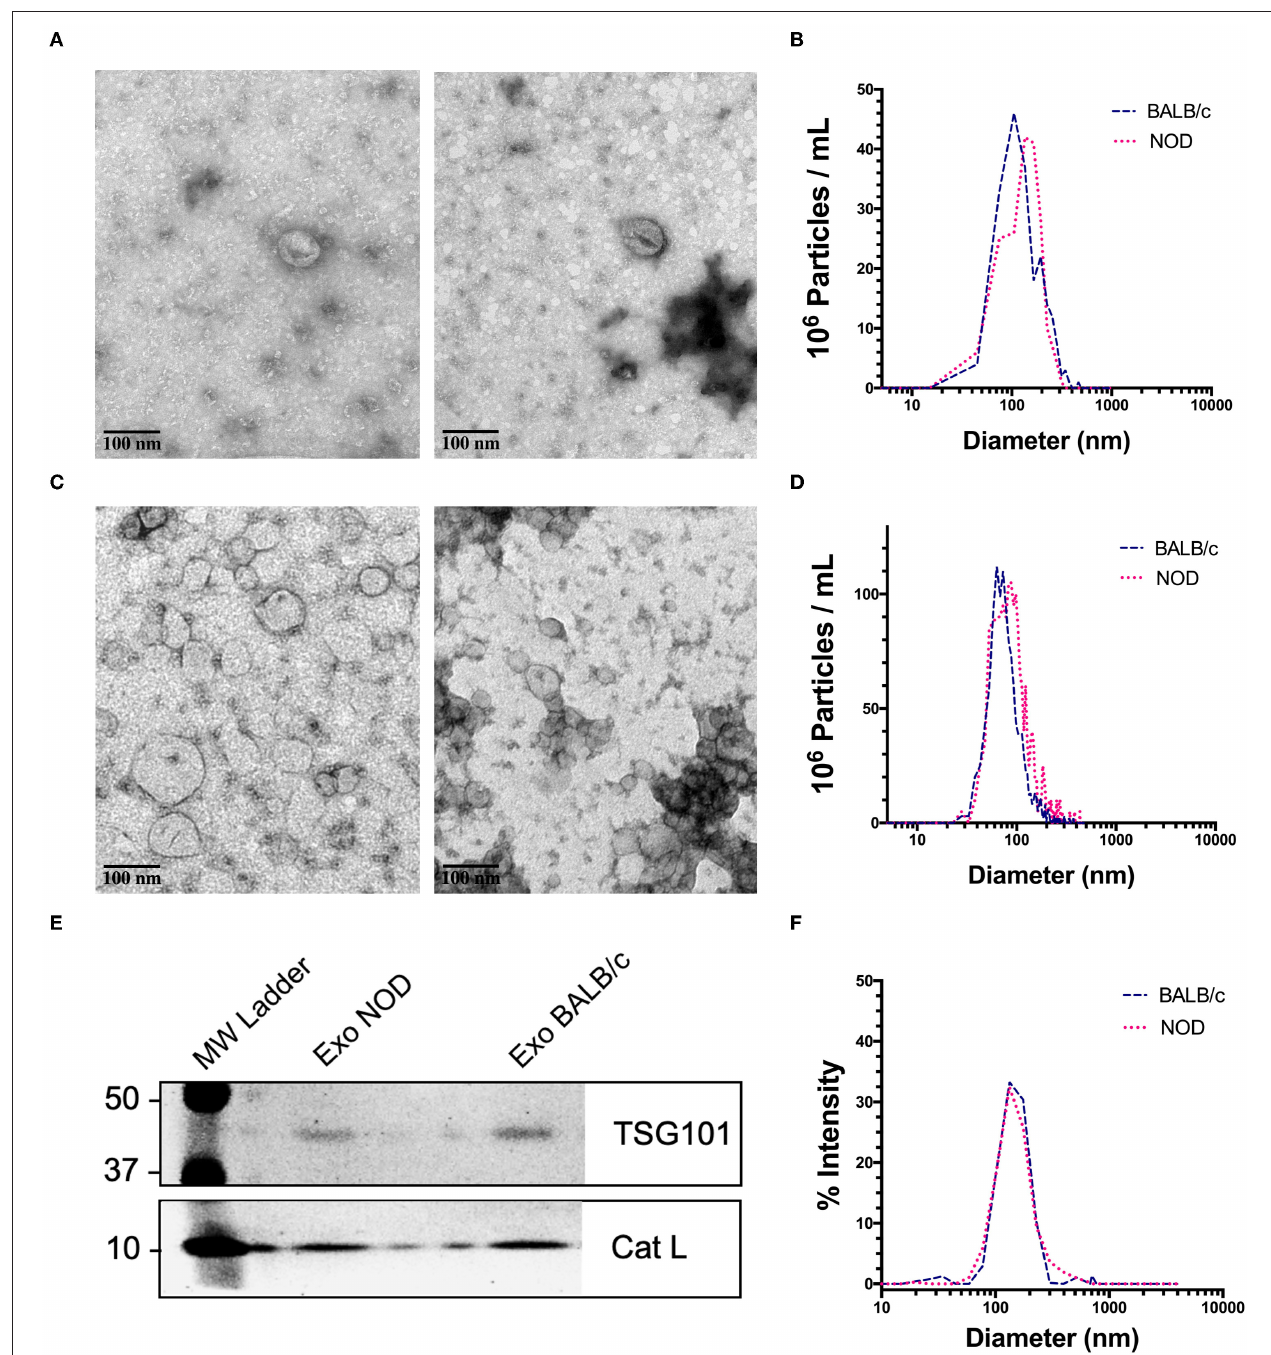
FIGURE 1 | Characterization of mouse serum-derived exosomes by differential Ultracentrifugation (UC) and Sice Exclusion Chromatography (SEC). (A) Transmission Electron Microscopy (TEM) images of exosomes isolated from NOD (left) and BALB/c (right) mouse serum using differential UC. The cup and saucer shaped morphology typical of exosomes is visible. (B) NTA showed median diameters of 136 and 131nm for serum exosomes from NOD and BALB/c mice, respectively. The graph is representative of four separate experiments per mouse strain. No significant differences in exosome median diameter were observed between the two strains. (C) TEM images of SEC exosomes isolated from NOD (left) and BALB/c (right) mouse serum. (D) NTA of SEC exosomes. (E) Western blotting of NOD and BALB/c serum exosomes isolated by SEC show enrichment of TSG101 and Cathepsin L. (F) Exosome particle size of SEC exosomes analyzed by DLS showed a median diameter of 122nm from both strains. The graph is representative of three separate